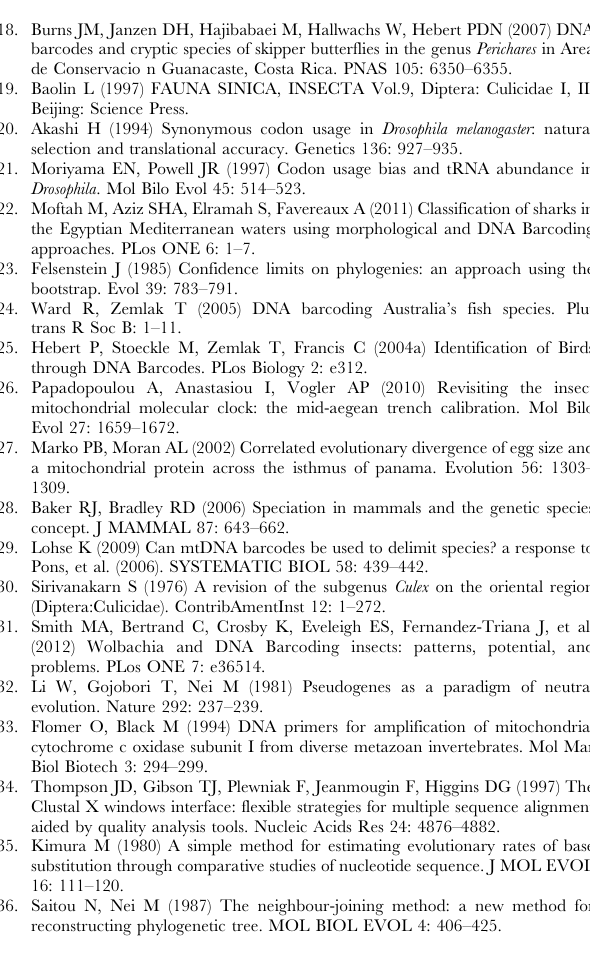
Table S1 Sequence divergence and nucleotide compo- sition for the mosquito genera. The frequencies of nucleotides in sequence are presented as the total average values for all Condon positions and for each condon position separately with the accuracy to tenths of a percent. (*) Figures in brackets are the number of mosquito species used to estimates of sequence divergence for the genus